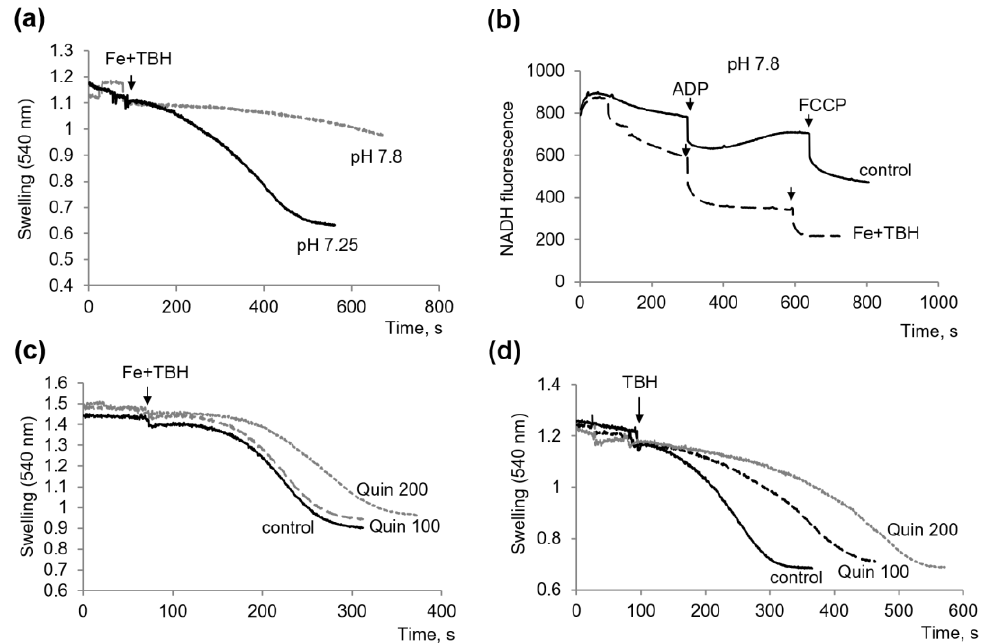
Figure 4. Influence of alkalization and quinidine on mitochondrial damage induced by TBH and ferrous ions. Influence of alkalization (pH 7.8) on the swelling ( a ) and oxidative phosphorylation ( b ) in the presence of TBH and ferrous ions; Influence of quinidine (Quin) at the indicated concentration on the swelling induced by TBH and ferrous ions ( c ) and TBH alone ( d ).